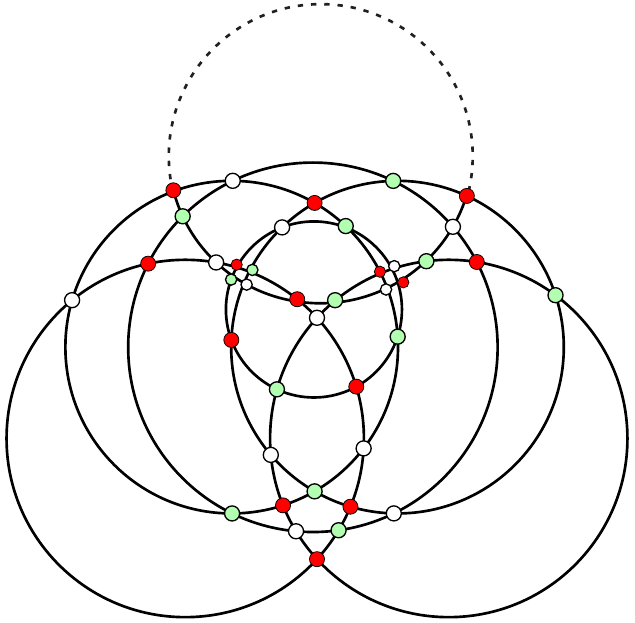
Figure 3: A 3-coloring of the graph K 2 − (1 , 4) .